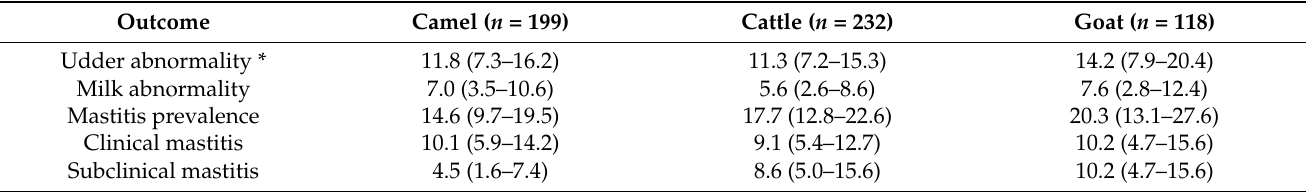
Table 3. Overall prevalence of udder and milk abnormalities, and prevalence of clinical mastitis by animal species. Outcome Camel ( n = 199) Cattle ( n =